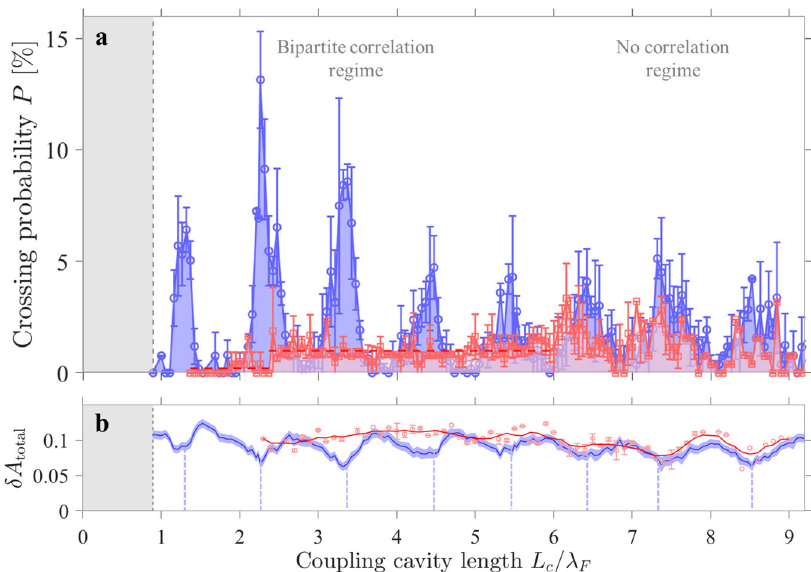
Fig. 3 Evolution of the transition probability with the width of the coupling cavity. a The dependence of the probability of tunneling from the outer to the inner cavity on the width of the coupling cavity, L c , for a single drop (red squares) and for two drops (blue circles). The red dashed line is the average tunneling probability for a single drop for coupling cavity lengths L c / λ F <6. For 2.3< L c / λ F < 6 this average probability 〈 P 〉 = 1.0% (95% con fi dence interval [0.91:1.09]). Error bars represent the standard deviation over six independent numerical runs. b Evolution of the energy barrier to tunneling, δ A total , for the two- droplet system (blue) and the one-droplet system (red). Blue shaded regions adjoining the lines denote the error bars. Note that the probability maxima in panel a correspond to energy-barrier minima in b . For L c / λ F >6, the tunneling probability of either drop converges to that of a single droplet, and so is evidently unaffected by its distant neighbor. The gray region on the left denotes the region of tall, slender coupling cavities that could not be reliably explored numerically.